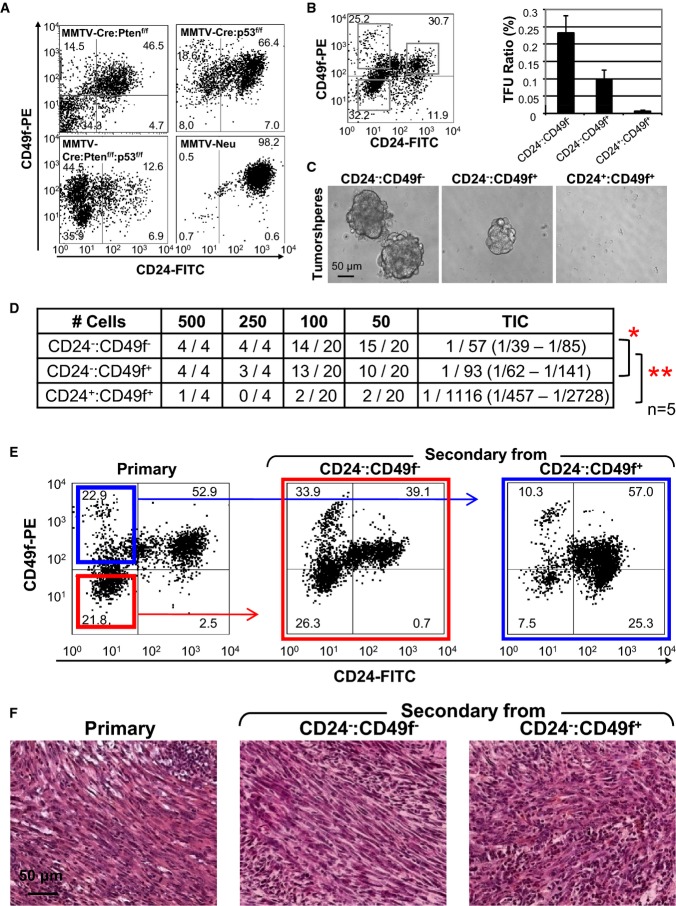
High frequency and unique tumor-initiating cells (TICs) in Pten/p53-deficient micFlow cytometry profiles of indicated tumors with the CD24 and CD49f cell surface markers.Gating conditions used to sort MMTV-Cre:Ptenf/f:p53f/f tumor cells into
CD24−:CD49f−, CD24−:CD49f+
and CD24+:CD49f+ fractions.
CD24−:CD49f− cells contained significantly higher
tumorsphere-forming units (TFU) at a frequency of 0.23%
(P < 0.00142, ANOVA with Tukey test for post
hoc) compared with CD24−:CD49f+ or
CD24+:CD49f+ fractions. The
CD24−:CD49f+ fraction contained TFU at a frequency of
0.10%
(P = 3.13 × 10−5, ANOVA
with Tukey test for post hoc) relative to the
CD24+:CD49f+ fraction.Representative images of tumorspheres from each fraction.TIC frequency in five MMTV-Cre:Ptenf/f:p53f/f tumors following cell sorting
and orthotopic transplantation into Rag1−/− females. There were too few
cells in the CD24+:CD49f− fraction for analysis. Significant
differences in TIC frequencies were determined using L-Calc (Stemcell Technologies) and ANOVA.
*P < 0.05;
**P < 0.001.CD24/CD49f profiles of primary and secondary tumors from transplantation of
CD24−:CD49f+ (blue) or
CD24−:CD49f− (red) MMTV-Cre:Ptenf/f:p53f/f
tumor cells.Representative mesenchymal-like histology of a primary
MMTV-Cre:Ptenf/f:p53f/f tumor and secondary tumors developed following
transplantation of CD24−:CD49f+ or
CD24−:CD49f− cell fractions.